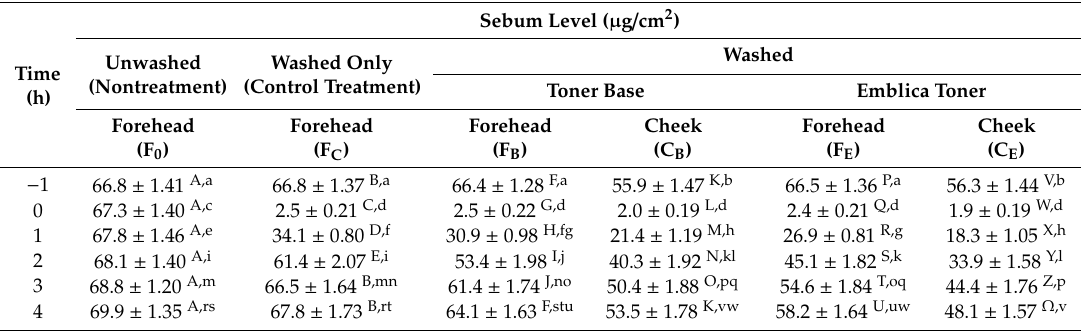
Table 2. The sebum level on the forehead and cheek skin (F C , F B , F E , C B , C E ) at − 1, 0, 1, 2, 3, and 4 h of 30 volunteers.